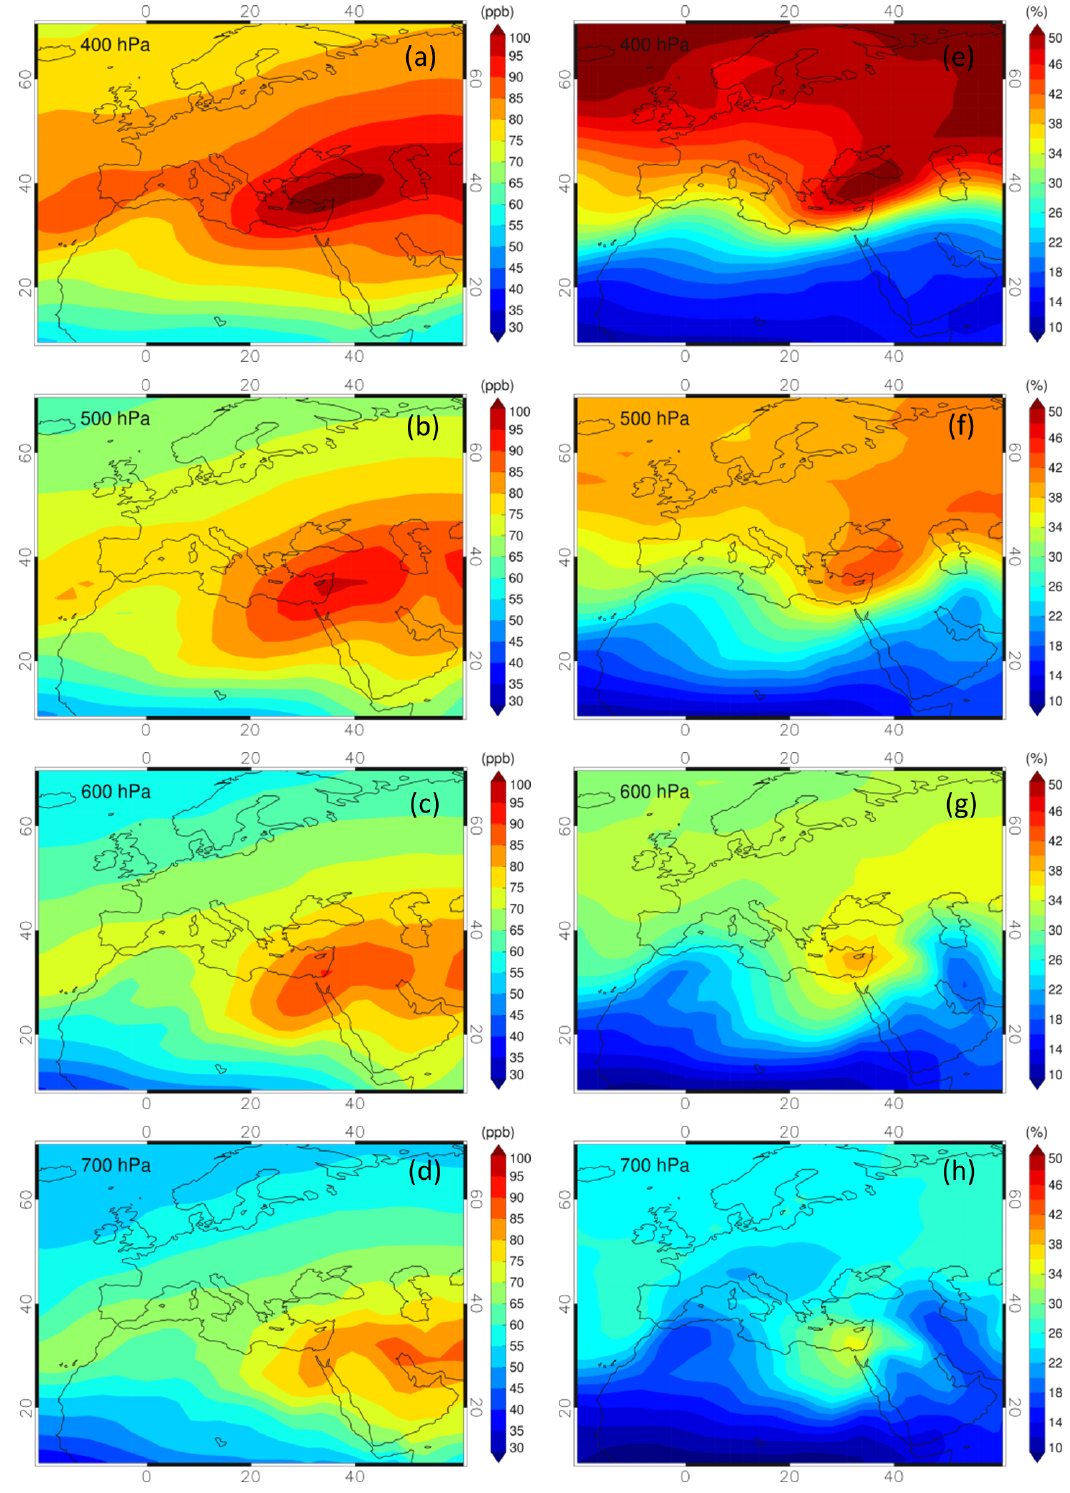
Figure 4. Spatial distribution of EMAC-simulated ozone (ppb) and stratospheric ozone contribution (%) averaged over the selected fold events of the period 1979–2013 at 400hPa (a, e) , 500hPa (b, f) , 600hPa (c, g) and 700hPa (d, h)